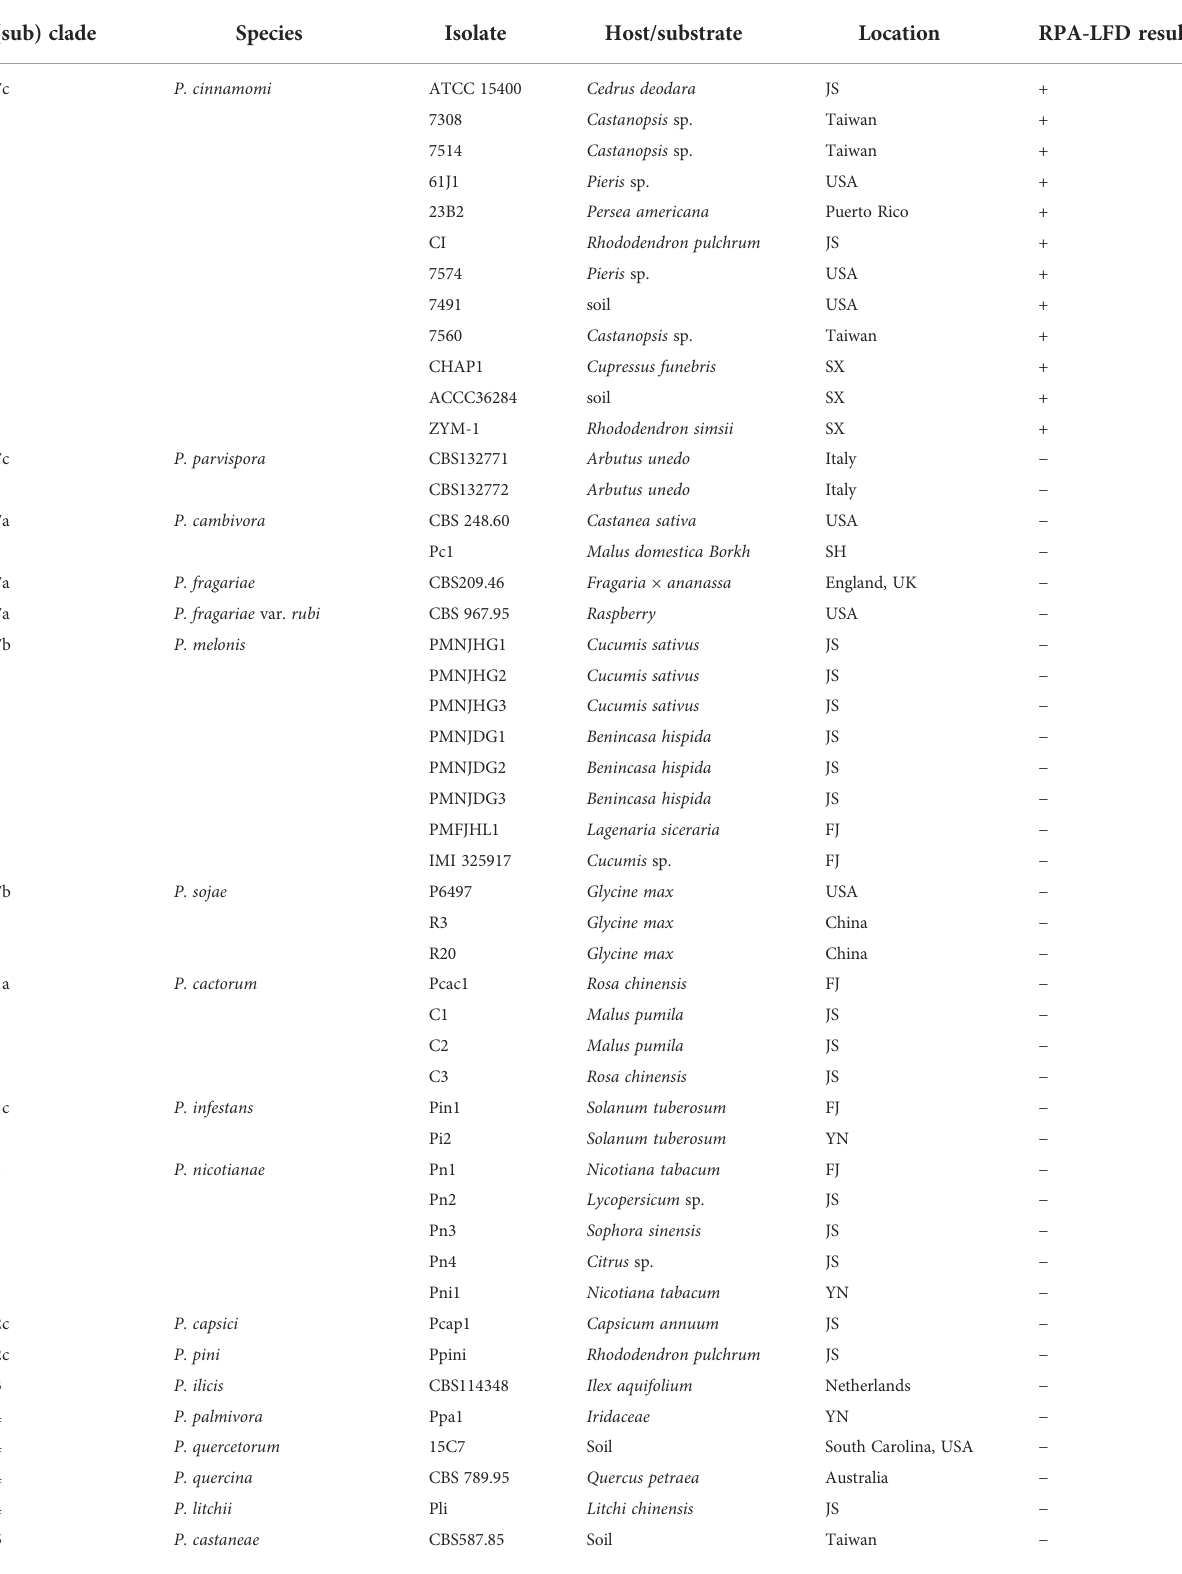
TABLE 1 Isolates used for speci fi city test of the RPA-LFD